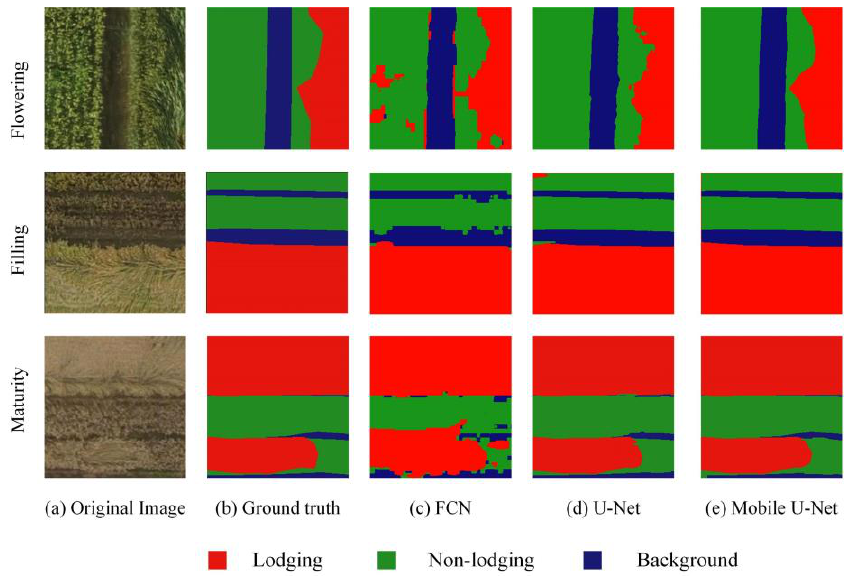
Figure 9. The results of estimating wheat lodging with different models with RGB + DSM.